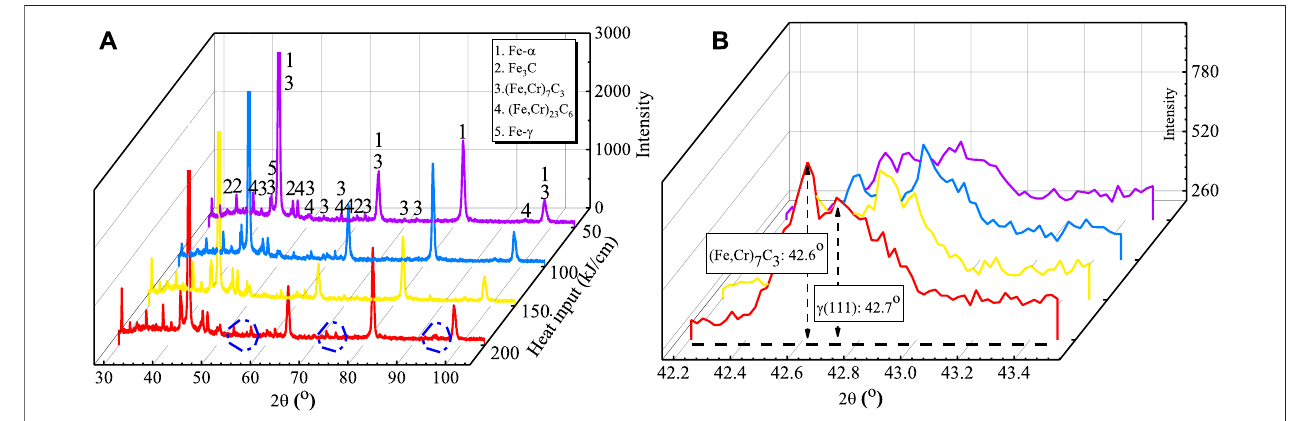
FIGURE 8 | (A) XRD spectrums and (B) magni fi ed images for a part of Figure 7A in the CGHAZ at different heat inputs.